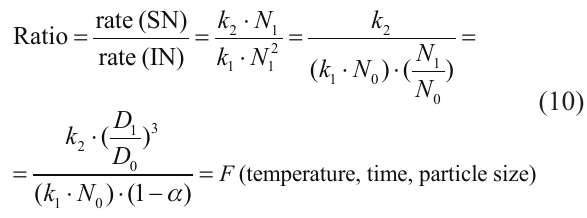
Table 1 – Parameters for the kinetic models (8) and (9) with m = 1, for transformation from anatase to rutile (Fig. 2)